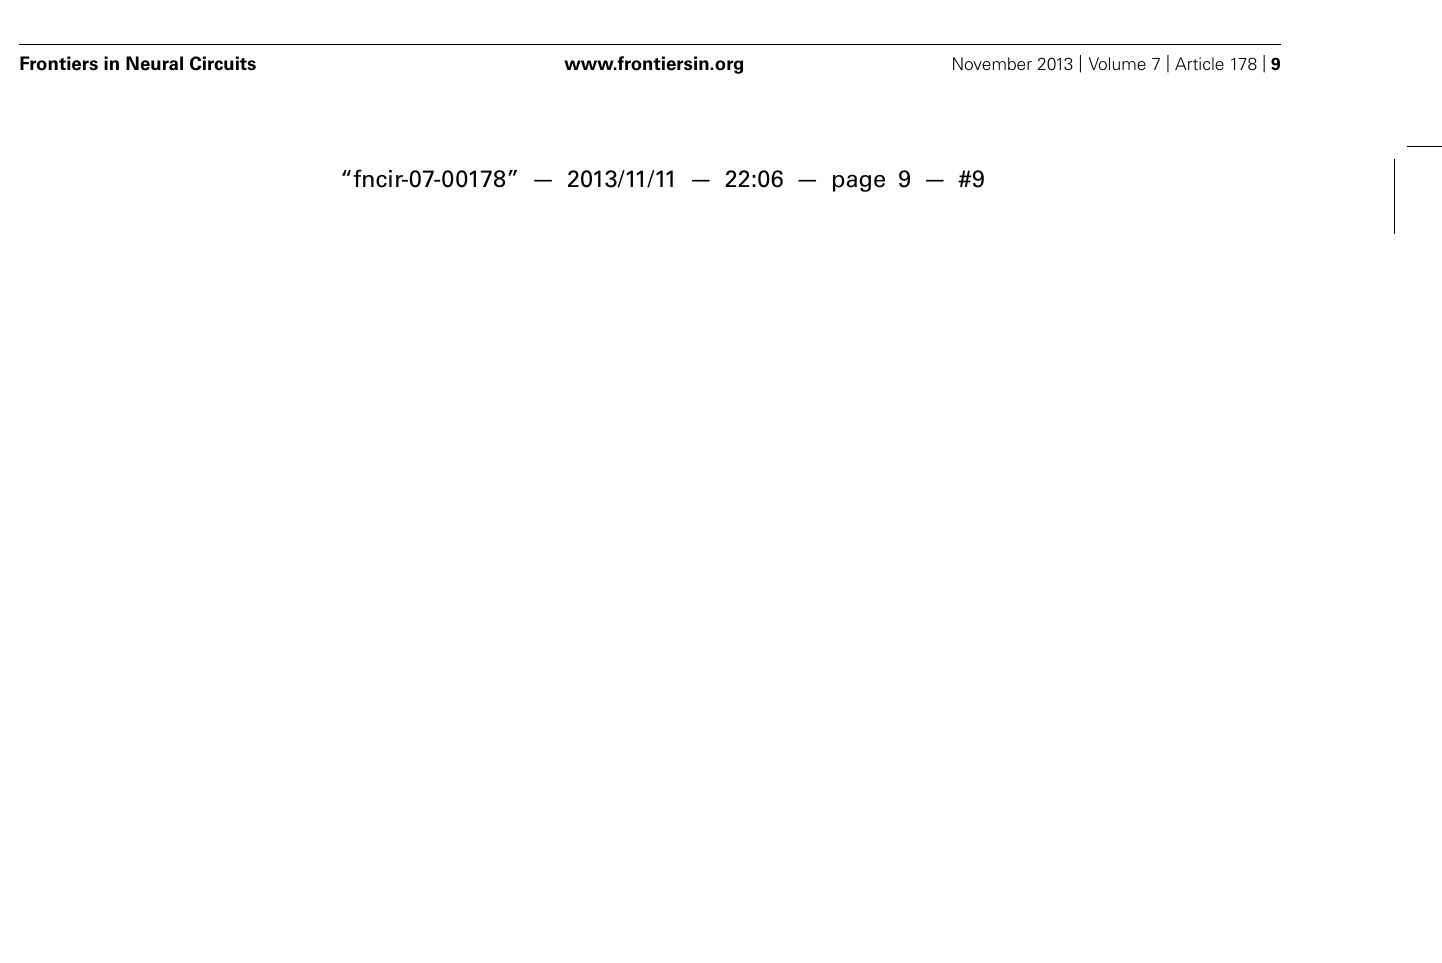
FIGURE 7 | Individual survival distributions of zebrafish sleep and wake bout lengths with corresponding stretched exponential and power-law fits. Survivor plots of (left panel) sleep and (right panel) wake bouts in zebrafish for age groups 6–10 days (blue), 4–6 weeks (green), 4–6 months (orange), and 12 months + (red). Each trace encompasses data from a single fish. On the left panel the axes are shown using semi-log coordinates and